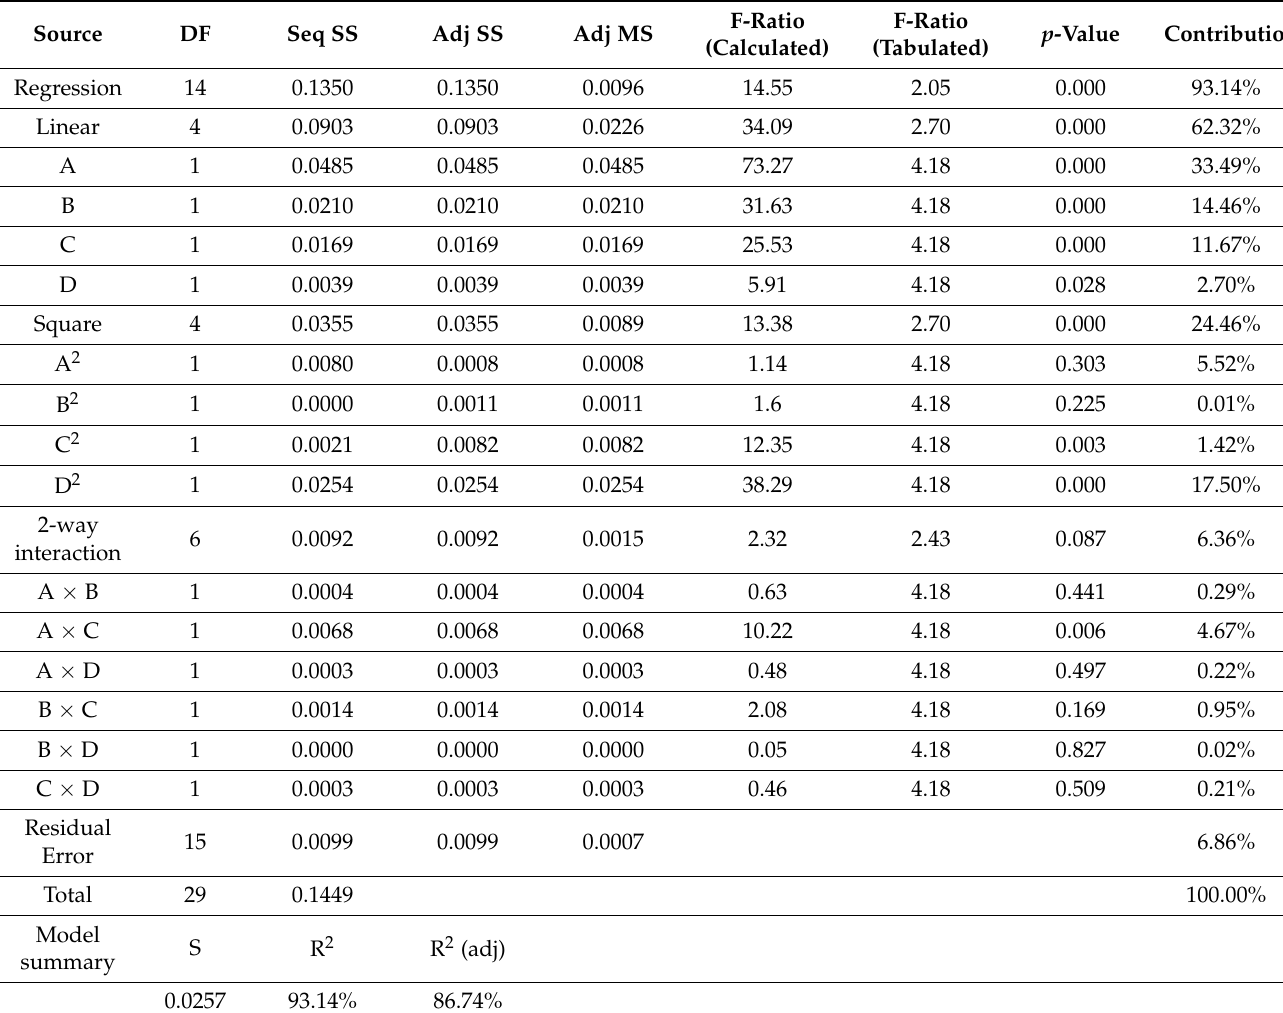
Table 17. ANOVA for delamination factor of h-BN-loaded